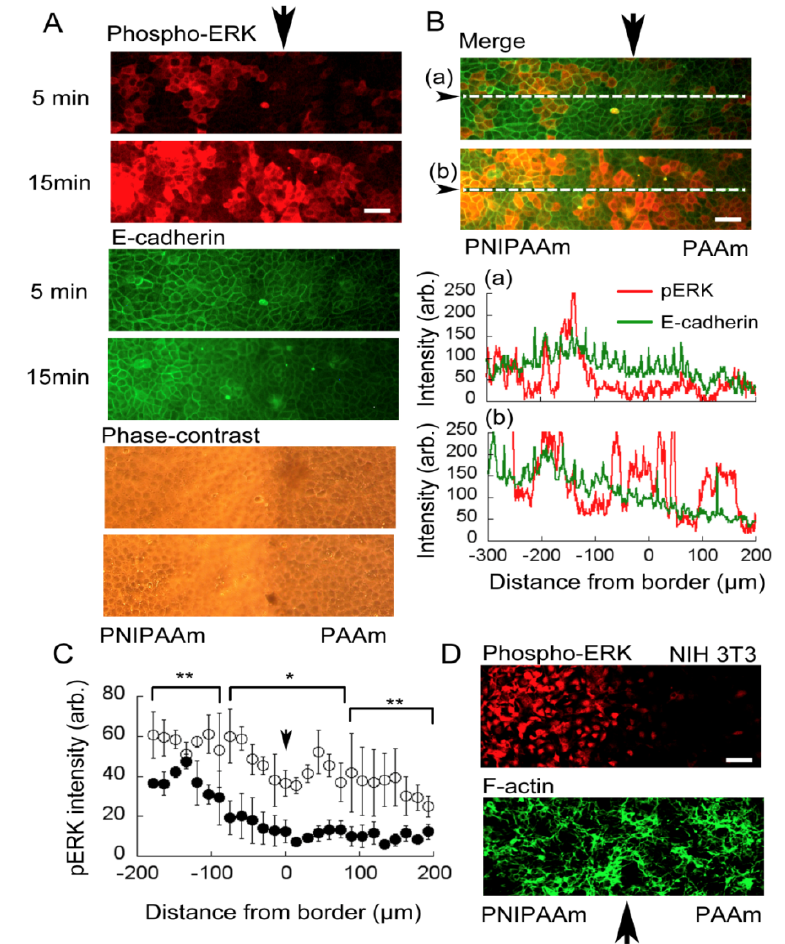
Figure 6. ( A ) Immunostaining of phosphorylated ERK1/2 and E-cadherin. Activation of ERK1/2 occurred within 5 min of the temperature change in the cells cultured on the collagen-immobilized PNIPAAm side. After 15 min, activation of ERK1/2 had propagated to the cells on the collagen-immobilized PAAm side include those more than 100 μ m from the border section. E-cadherin of cells on collagen-immoblized PNIPAAm side was stained more strongly than that in cells on the collagen-immobilized PAAm side, although the staining pattern was not propagated. The black arrows indicate the border between the two gels. Scale bar: 50 μ m; ( B ) Merged image of phospho-ERK and E-cadherin on ( A ). (a) and (b) are one pixel width intensity profiles on dashed line in each 5 min and 15 min image. The X-axis denotes the location of the combined gel, zero represents the border section, minus sign represent the PNIPAAm side, and plus sign represent PAAm gel side. No particular correlation intensity between phospho-ERK and E-cadherin was observed; ( C ) Fluorescence intensity profiles of phosphorylated ERK1/2. Closed circle; after 5min after temperature decrease. Open circle, after 15min of temperature decrease. Profiles are averages of three different section images from each of three independent experiments. Vales are mean ± SEM ( n = 3). Statistical analysis between 5 min and 15 min images of each correspond plots were * p < 0.01, ** p < 0.05; ( D ) Immunostaining of phosphorylated ERK1/2 of NIH 3T3. Even after 15 min of a temperature decrease, ERK1/2 phosphorylated cells were few on PAAm